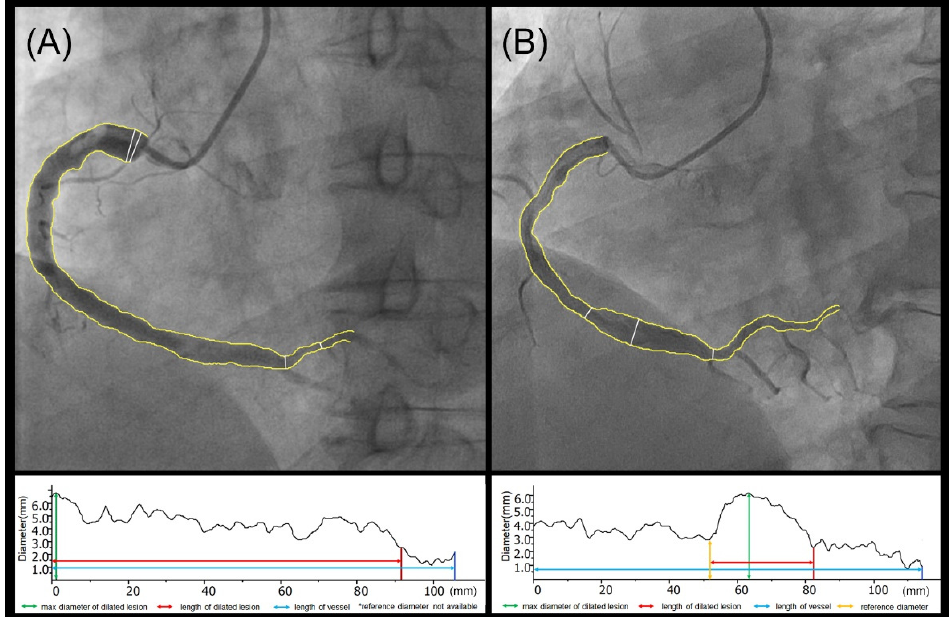
Figure 2. Instruction for QCA measurement. Examples for QCA measurement of a diffuse dilated lesion with no adjacent normal segment ( A ) and a focal dilated lesion with adjacent normal segment ( B ).